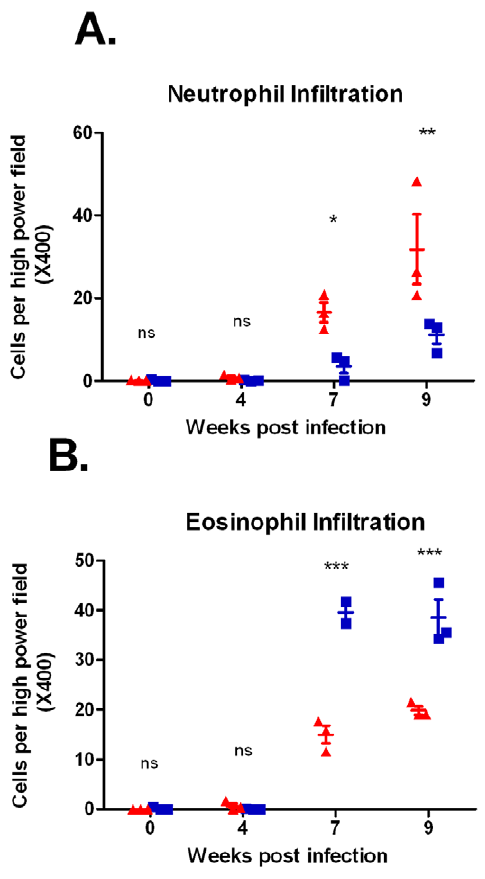
Figure 3. Comparison of cell infiltration in CBA mice and BALB/ c mice. Hepatic neutrophil infiltration ( A ) was markedly higher in BALB/ c mice compared to CBA mice. Conversely, eosinophil numbers ( B ) were significantly greater in CBA mice compared to BALB/c mice. Statistical significance between strains was determined using 2-Way ANOVA with Bonferroni post hoc tests. m =BALB/c replicates, & =CBA replicates, ***=p , 0.001, **=p , 0.01, *=p , 0.05, ns=no significant difference. Error bars represent mean with standard error of the mean